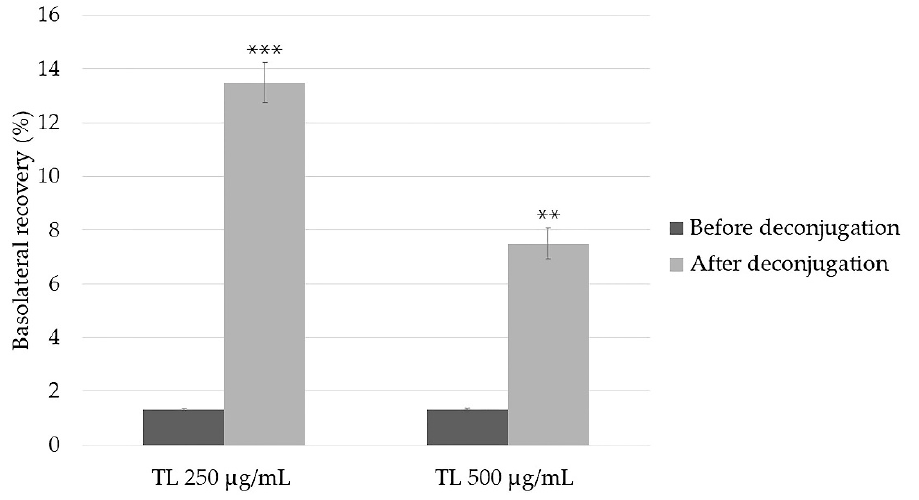
Figure 6. The basolateral recoveries of RA in 250 and 500 μ g / mL TL extracts after deconjugation with β‐ glucuronidase/sulfatase. Data are the mean ± SD from three replicates . ** and *** were significantly different from data obtained for samples, which were not deconjugated ( p < 0.01 and 0.001, respectively).